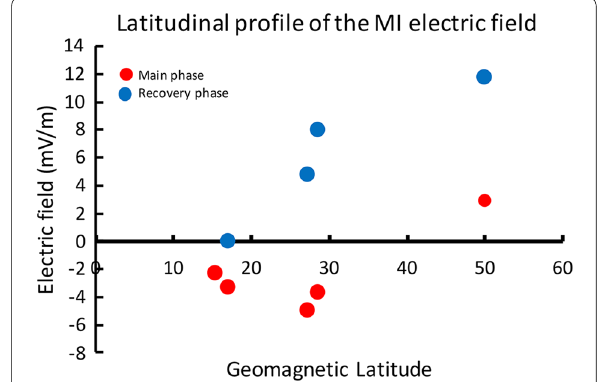
Fig. 5 Latitude profile of the main phase electric field (red) and overshielding electric field (blue). The main phase electric field is negative in the night, while positive in the evening. The overshielding electric field is positive at all stations located in the